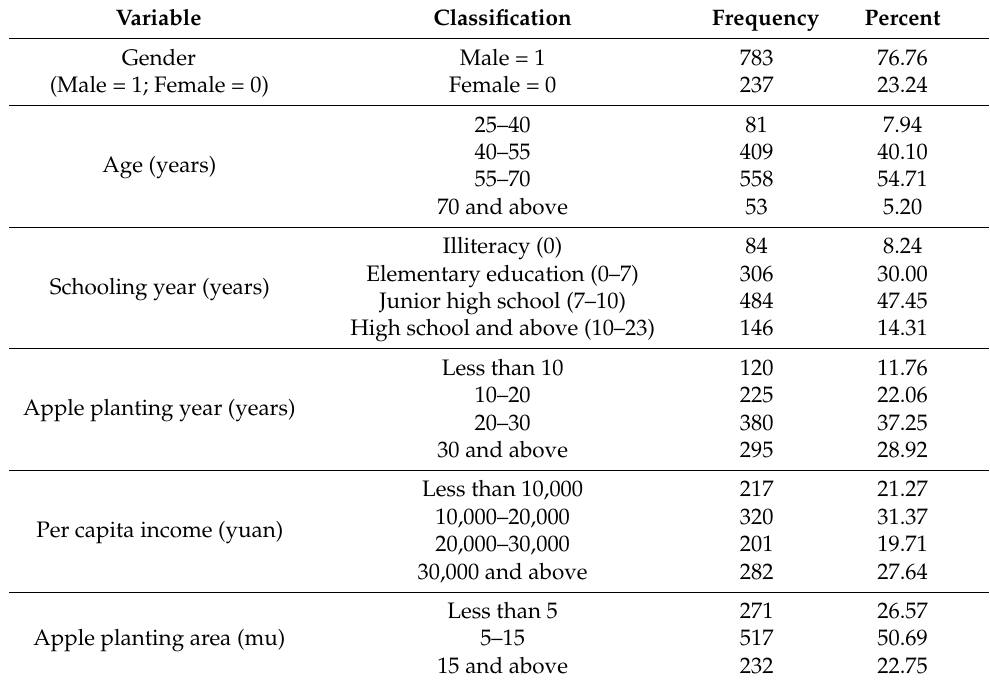
Table 1. Sample statistical